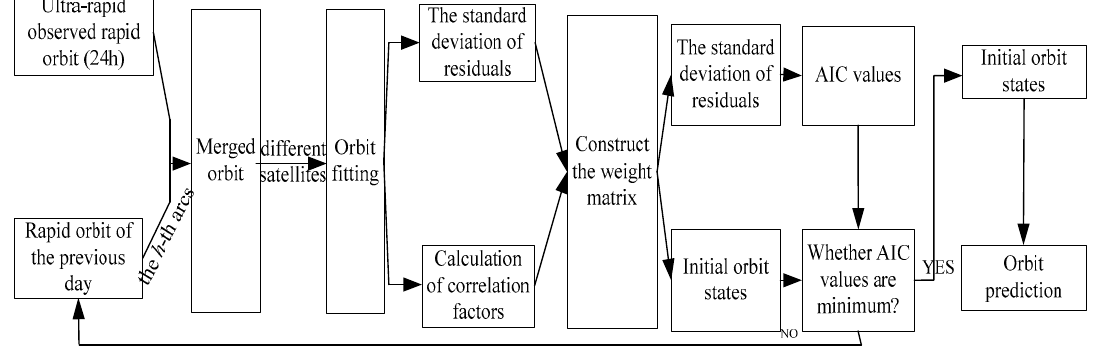
Figure 4. Improved model of the initial orbit state for the predicted orbit.